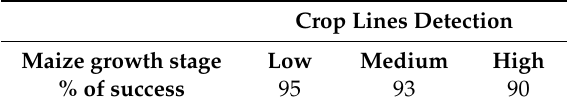
Table 4. Percentage of success for crop lines detection for three (low, medium, high) maize growth